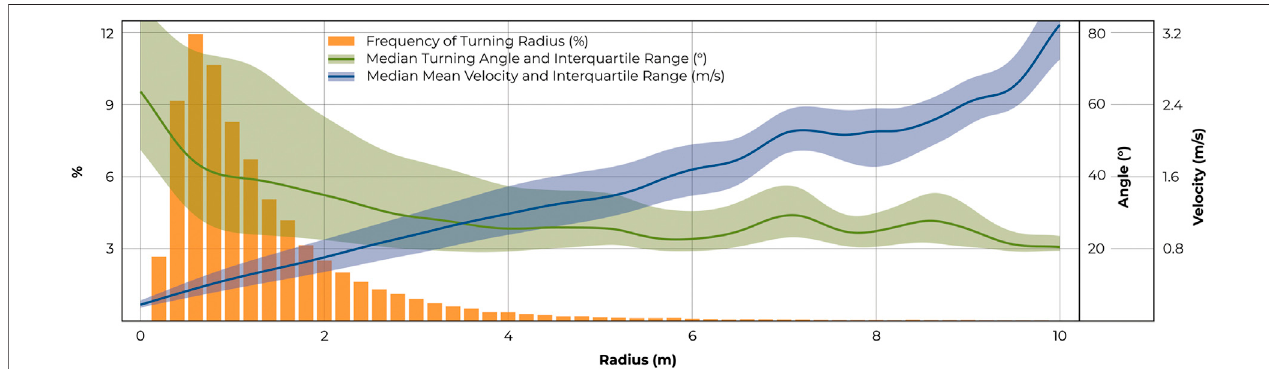
FIGURE 5 | Relationships between turning radii, angles, and velocities for regular moving turns. Records were discretised according to turning radius in steps of 0.2 m. Frequencies are shown in orange with respective median turning angles overlayed in green and median mean velocity (for moving turns) in blue. Shaded areas indicate the interquartile ranges.